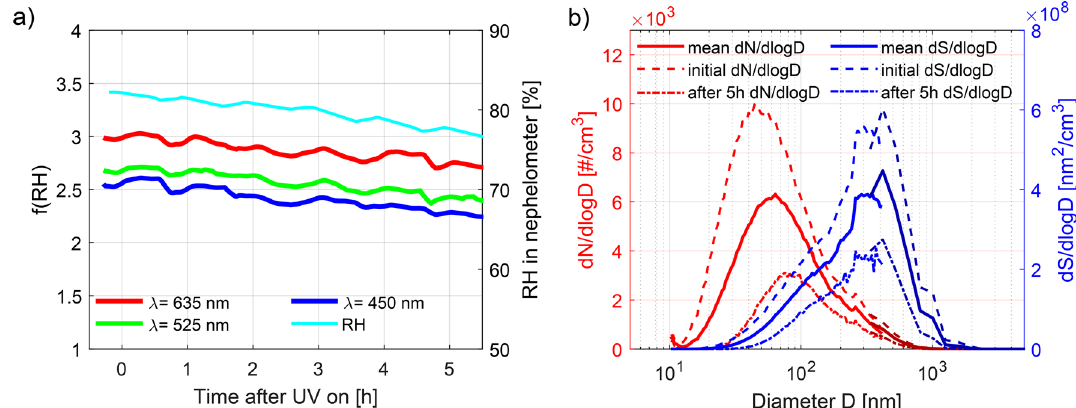
Figure 2. Hygroscopicity of larger sized sea salt particles (Exp. 15). ( a ) Scattering enhancement factor (f(RH)) measured at 3 different wavelengths ( (cid:31) = 450 nm, (cid:31) = 525 nm, (cid:31) = 635 nm) and RH in the nephelometer. ( b ) number (red lines; left y-axis) and surface distributions (blue lines; right y-axis) at the beginning, after 5 hours and mean distributions throughout the experiment as derived from combined scanning mobility particle sizer and optical particle spectrometer